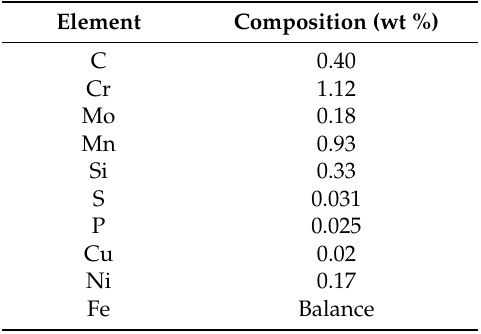
Table 1. Chemical Composition of the 4140 Alloy